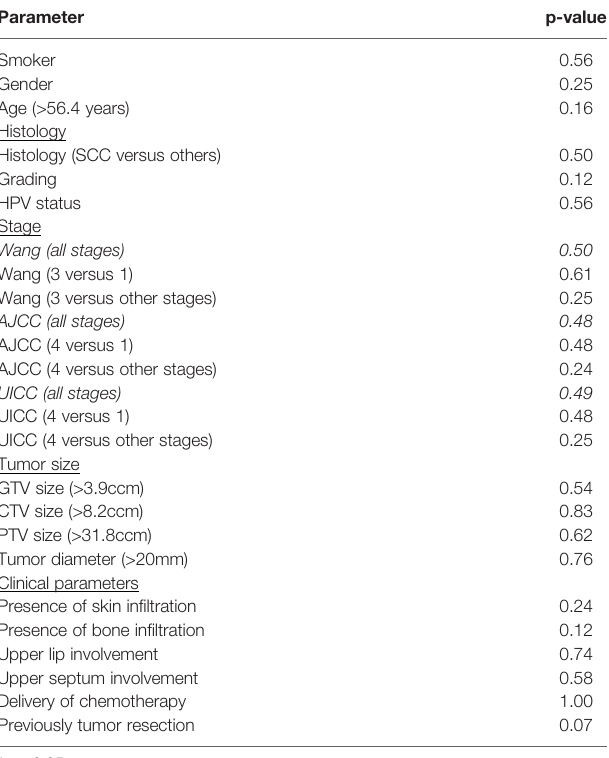
TABLE 6 | Univariate analyses on organ-preserving survival (OPS) (Log Rank